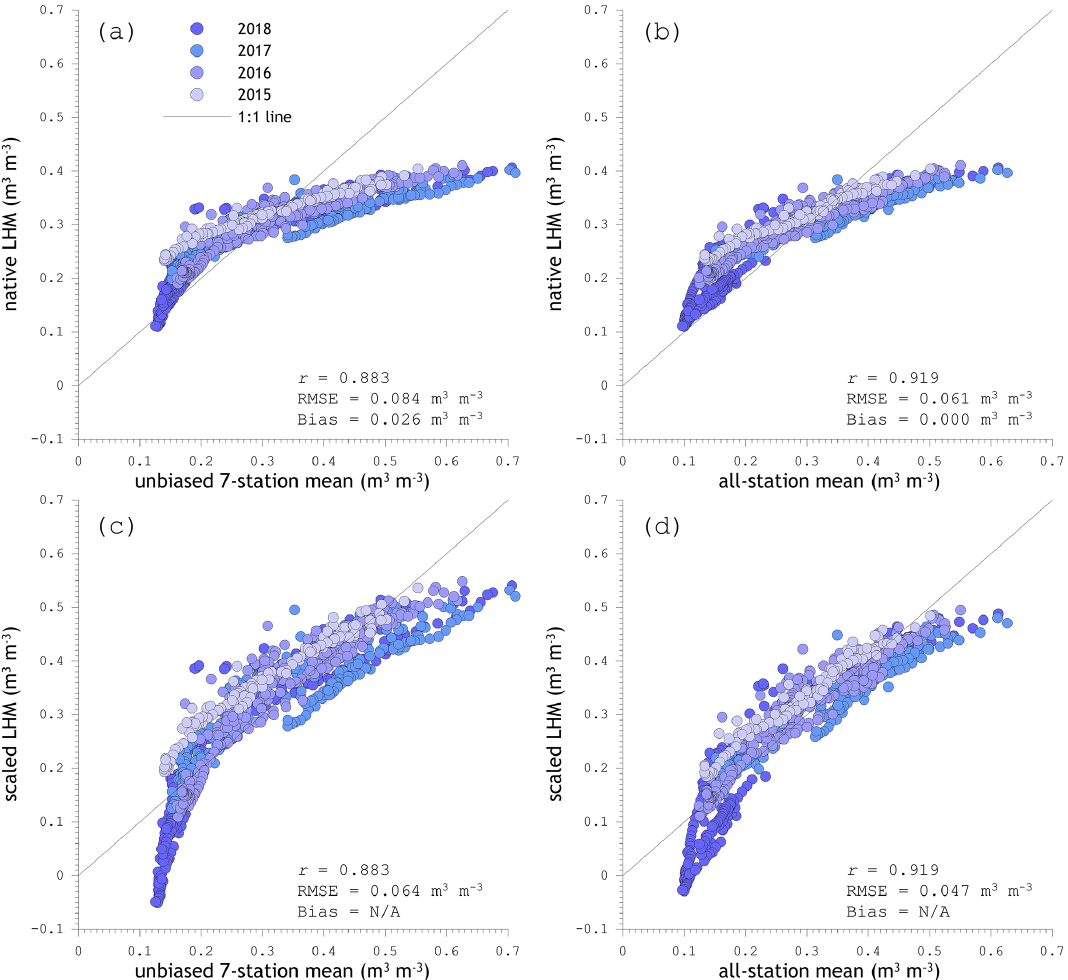
Figure 6. LHM-simulated spatial mean soil moisture against references deduced from in situ measurements for SMAP reference pixel 4371; panels (a) and (b) show the native LHM simulations versus the unbiased seven-station mean and all-station mean, respectively; panels (c) and (d) presented the same as panels (a) and (b) ; only LHM soil moisture is scaled to the statistical moments (1st and 2nd) of the in situ